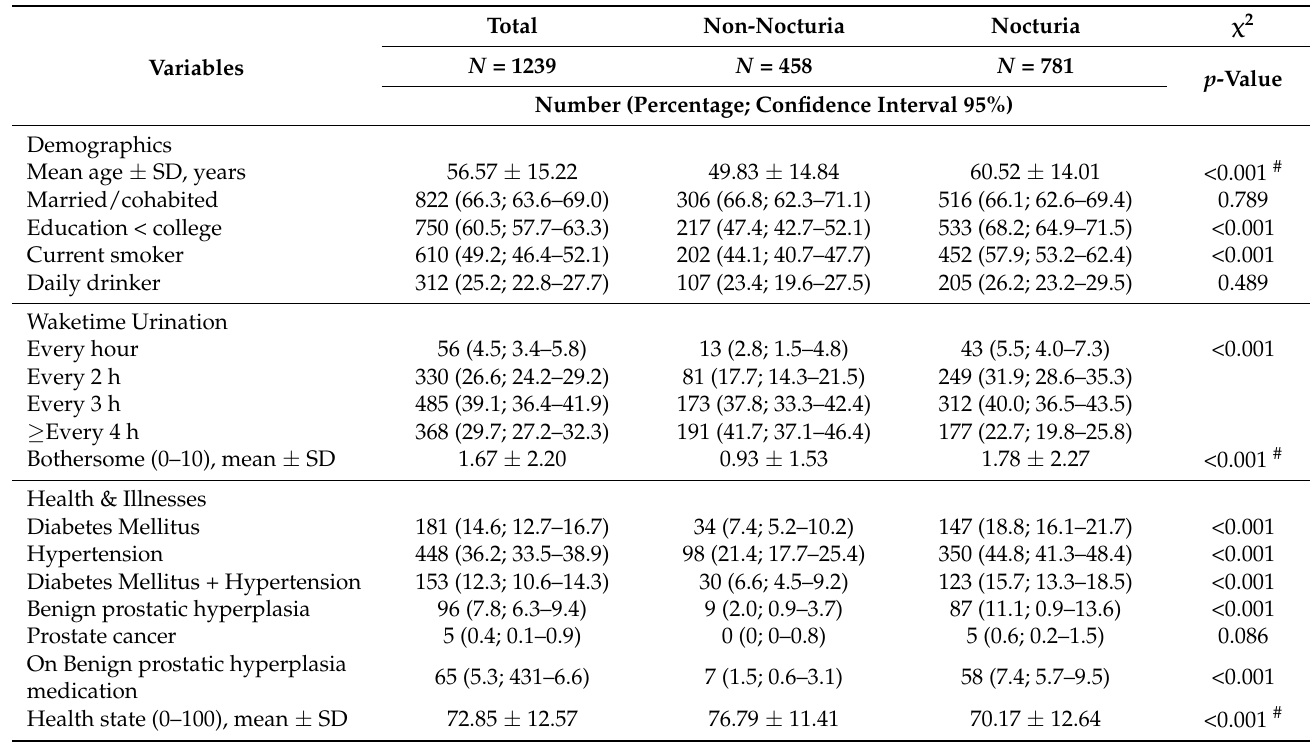
Table 1. Characteristics of the studied populations, and comparisons between individuals with and without nocturia.